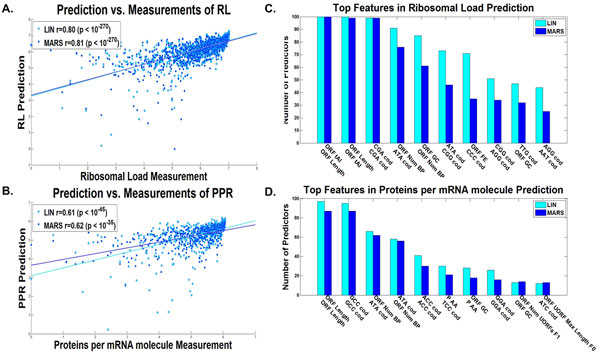
ORF linear and non-linear predictors results. Dot plot of the predictions vs. estimated measurements for the validation set of the predictor with the median results for the A. ribosomal load, and B. proteins per mRNA molecule, for the ORF linear (LIN) and non-linear (MARS)predictors (Additional file 1: Supplementary Methods). The best features according to the number of predictors they participated in (Additional file 1: Supplementary Methods) of the C. ribosomal load predictor, and D. proteins per mRNA molecule predictor, for the ORF linear (LIN) and non-linear (MARS) predictors (Additional file 1: Supplementary Methods).